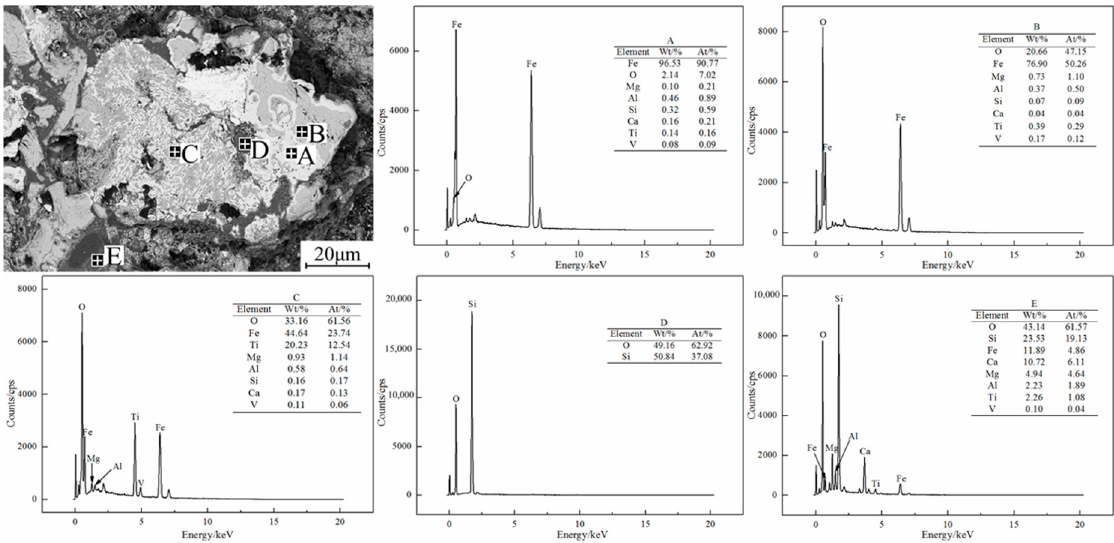
Figure 19. EDS diagrams of the oxidized pellets with 40% sea sand ore reduced at 900 °C for 3 h.